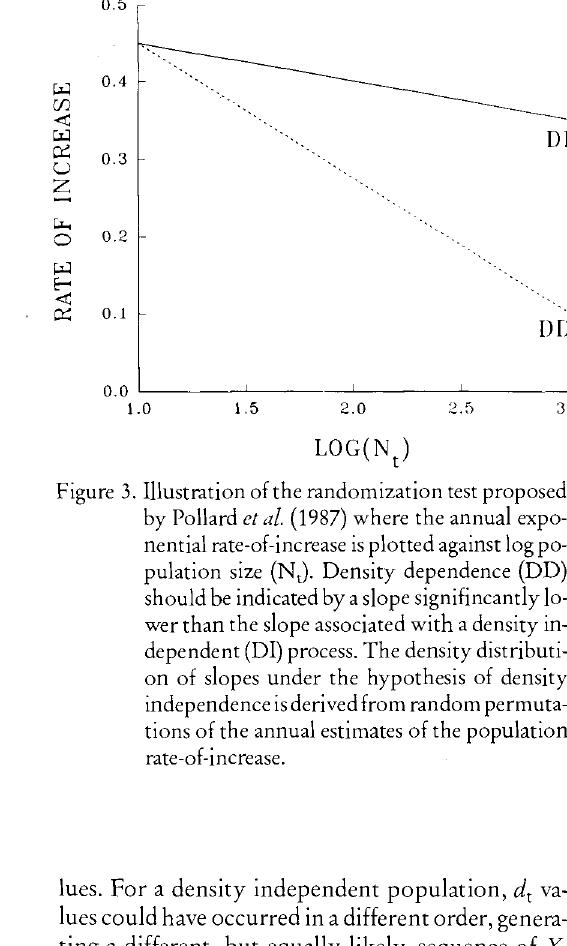
Figure 3. Illustration of the randomization test proposed by Pollard et al. (1987) where the annual expo nential rate-of-increase is plotted against log po pulation size (N t ). Density dependence (DD) should be indicated by a slope signifincantly lo wer than the slope associated with a density in dependent (DI) process. The density distributi on of slopes under the hypothesis of density independence is derived from random permuta tions of the annual estimates of the population rate-of-increase.